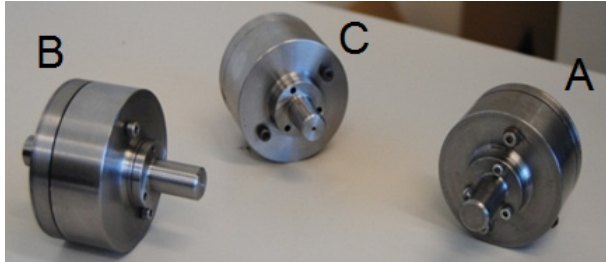
Figure 6: Manufactured